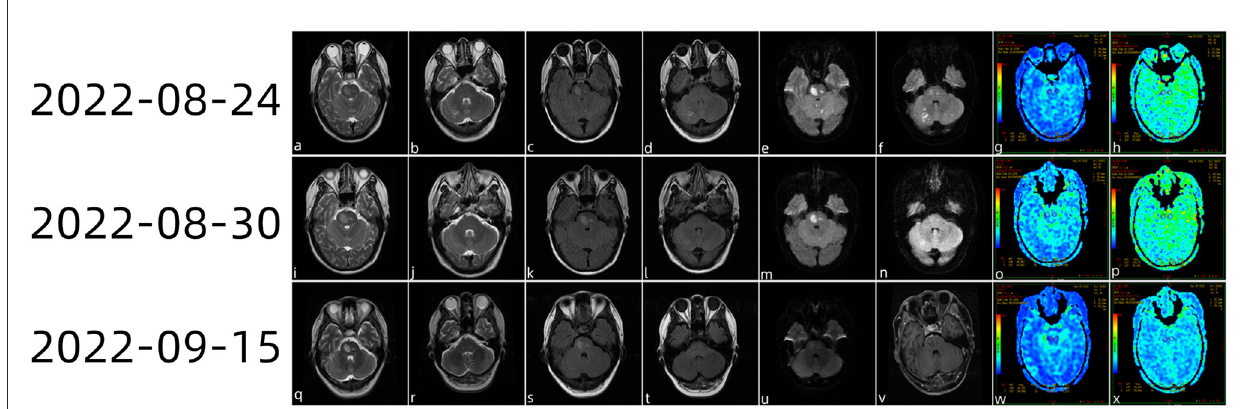
FIGURE1 Head magnetic resonance imaging (MRI) plain scan 3.0 examination diagnosis (a–f) on 24 August 2022 showing multiple acute foci in the brainstem and bilateral cerebellar hemispheres. ASL (g, h) showed a mild reduction in the perfusion of the lesions. On 30 August 2022, the cranial MRI (i–n) showed that the bilateral cerebellar acute infarction had improved and that the brainstem acute infarction had reduced slightly. ASL revealed slight hypoperfusion when PLD (o) was 1.5s and the cerebral stem perfusion was similar to that of the contralateral side at 2.5s (p). On 15 September 2022, the patient came to the hospital for review (q–x); brain stem lesions were smaller than those of half a month ago, while magnetic resonance enhancement of the brain showed (v) heterogeneous enhanced foci in the brain